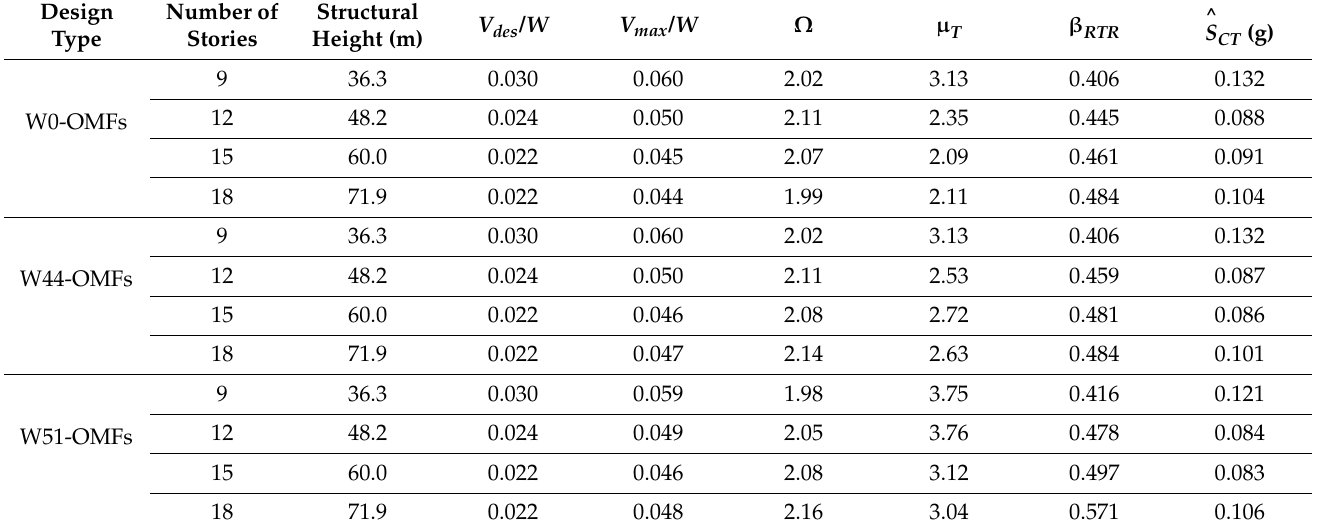
Table 2. Parameters from pushover and IDA